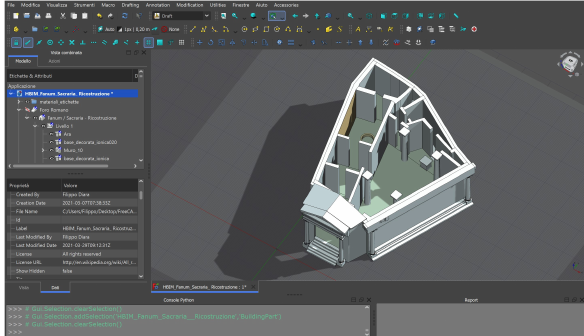
Figure 8 . Hypothetical reconstruction model with internal subdivision details: in particular the courtyard with columns; the Sacrarium Martis with fireplace.